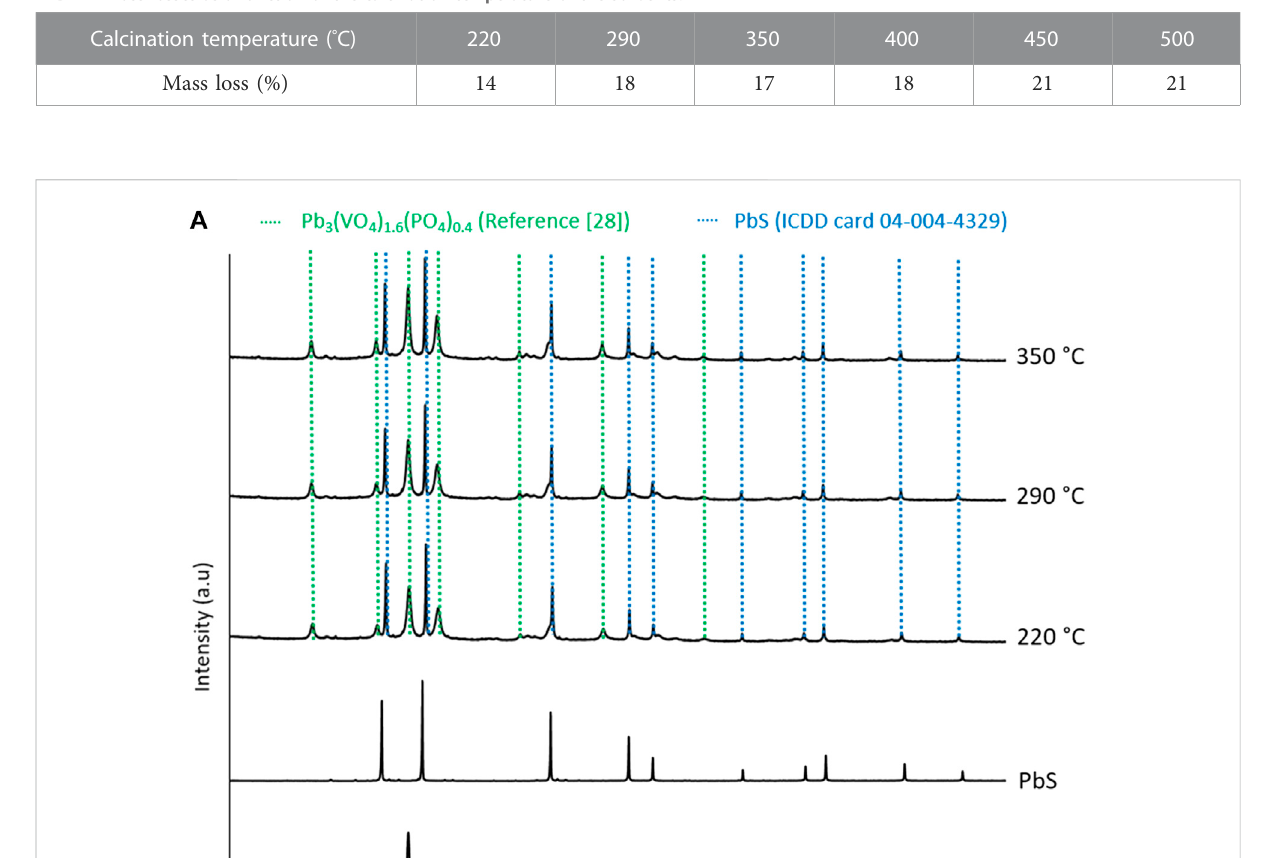
TABLE 1 Mass losses as a function of the calcination temperature of the sorbents.